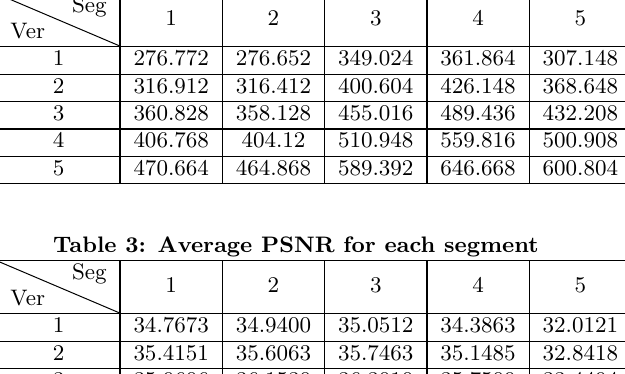
Table 1: The con(cid:12)gurations of the LTE network RB number 10 Active UE number